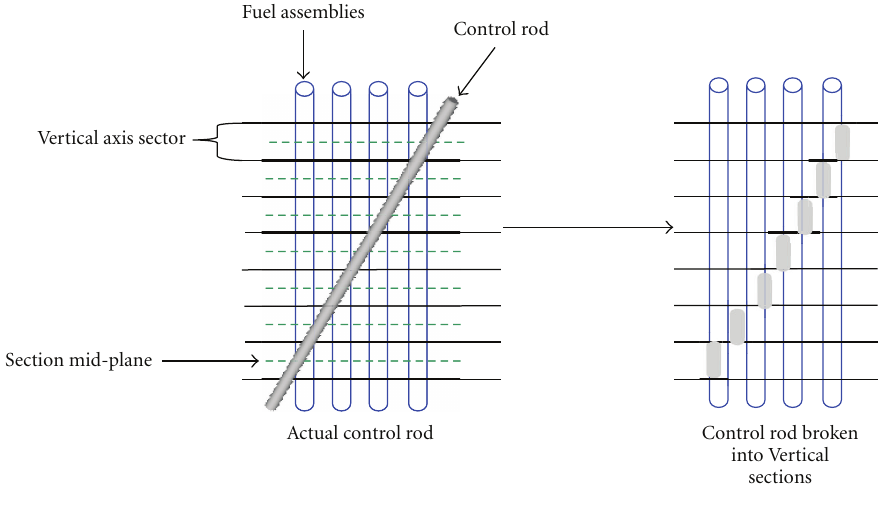
Figure 8: Control rod representation in PUMA.